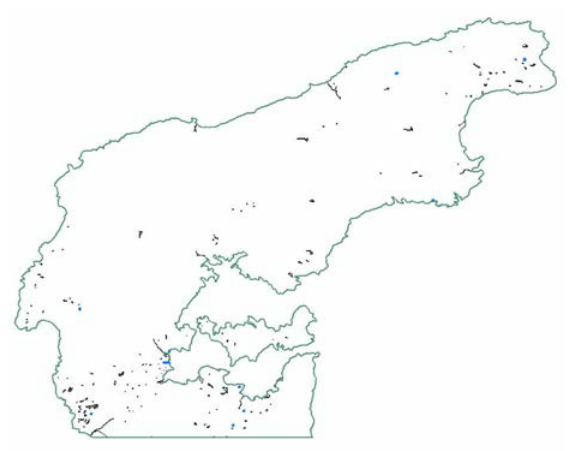
Figure 4. Samples in stratum of polygons (blue polygons represent samples).